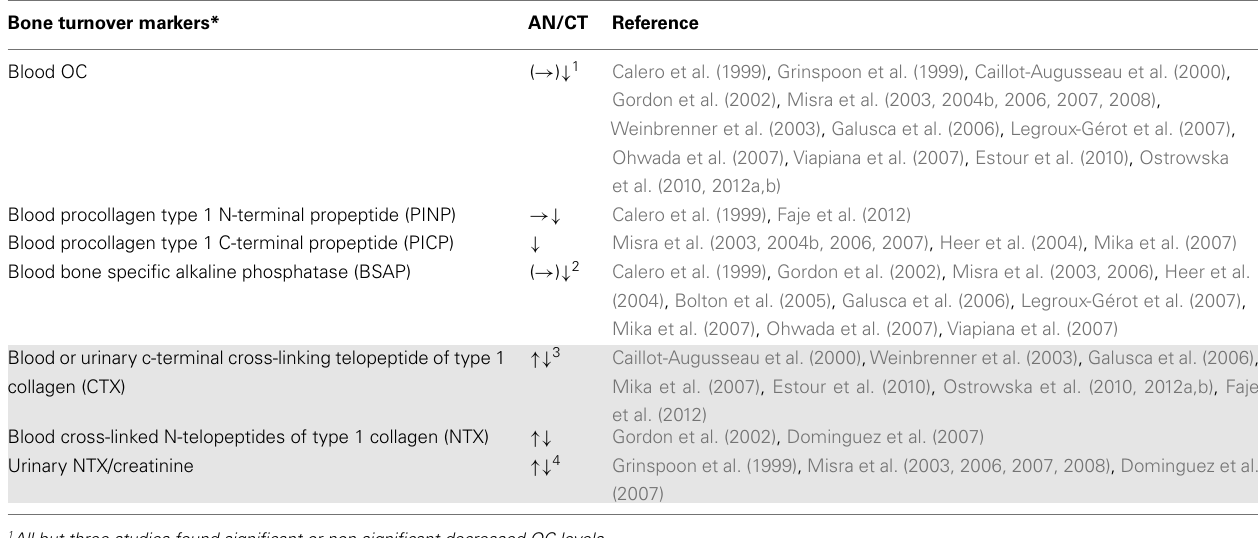
Table 5 | Compared levels of bone turnover markers inAN patients and healthy matched population. Bone turnover